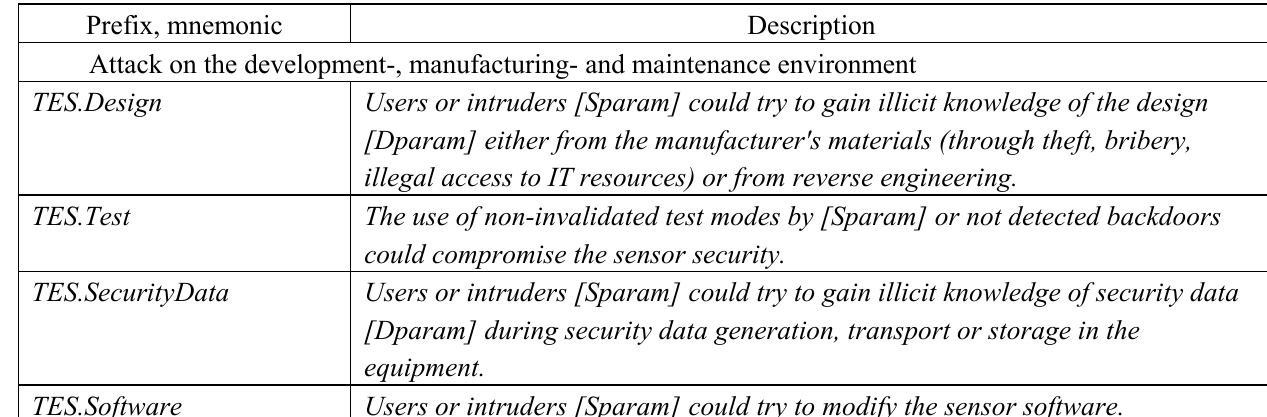
Table 12. Threats related to the TOE development-, manufacturing- and maintaining processes expressed by enhanced generics (considered